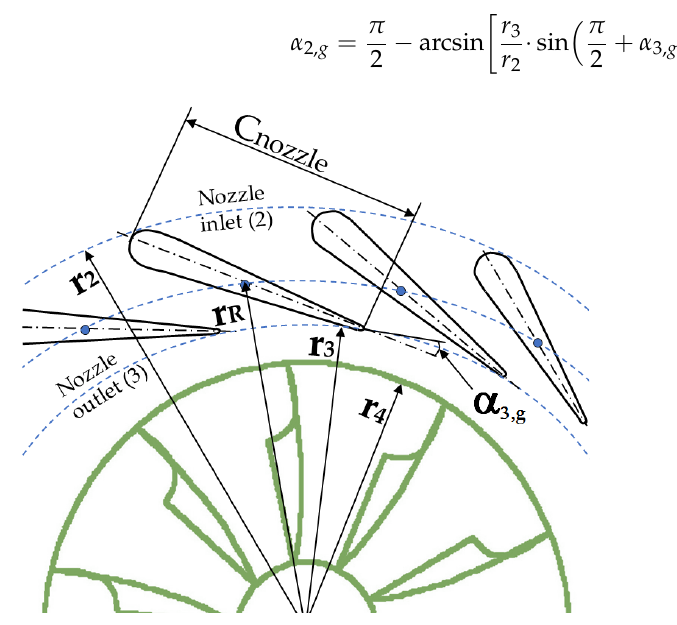
Figure 7. Schematic representation of nozzle geometry. Figure 6. Geometric representation of the nozzle.